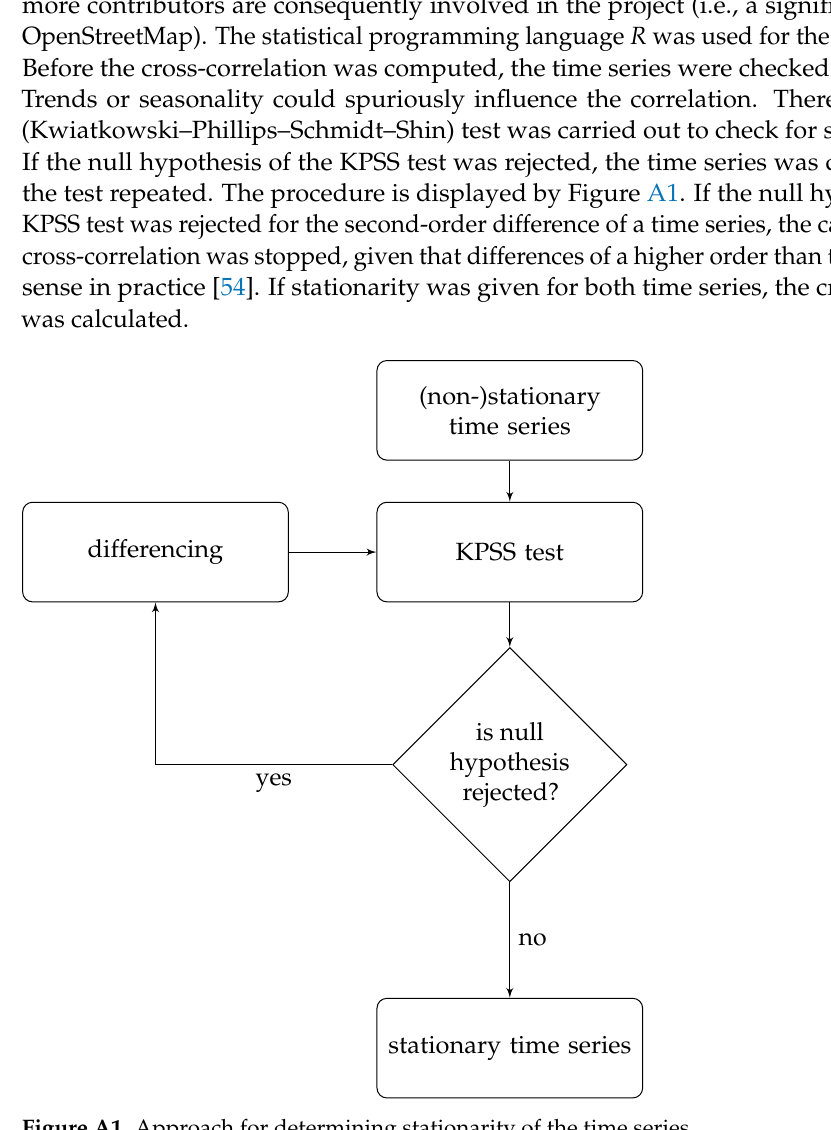
Figure A1. Approach for determining stationarity of the time series. During the cross-correlation analysis, it was found that the time series of the count of elements during an import could not be stationarised by differencing the data, given the nonlinear growth of